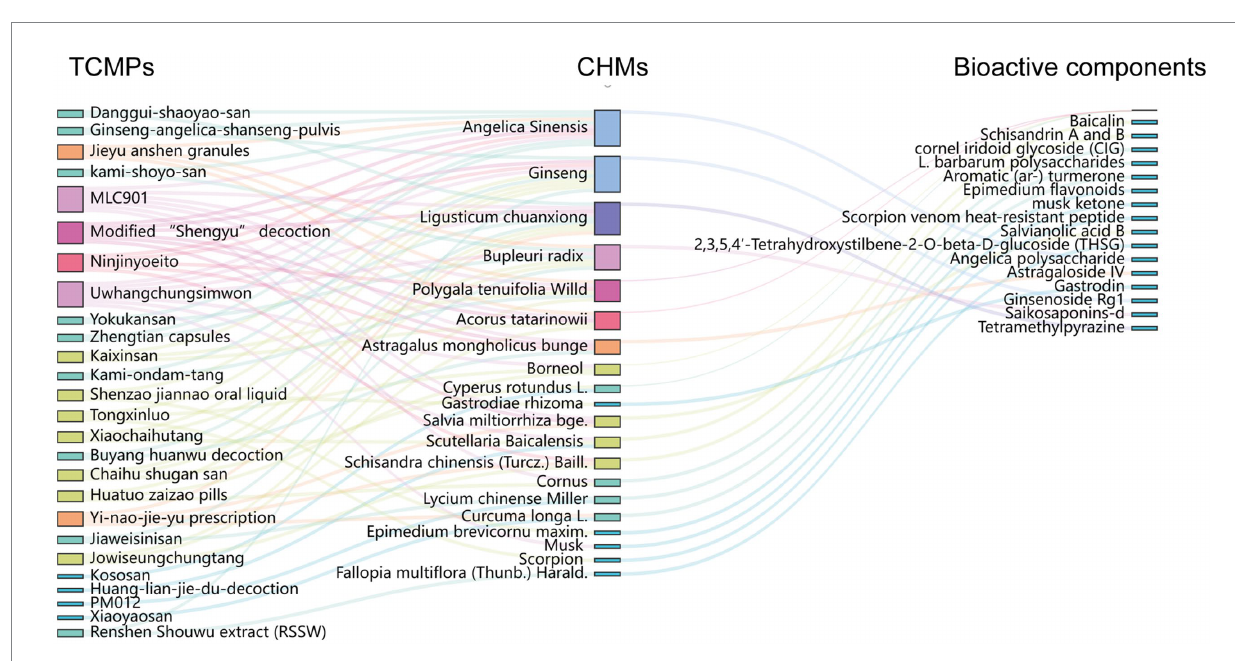
FIGURE 6 TCMPs and CHMs are commonly used to enhance adult neurogenesis and a network of its bioactive